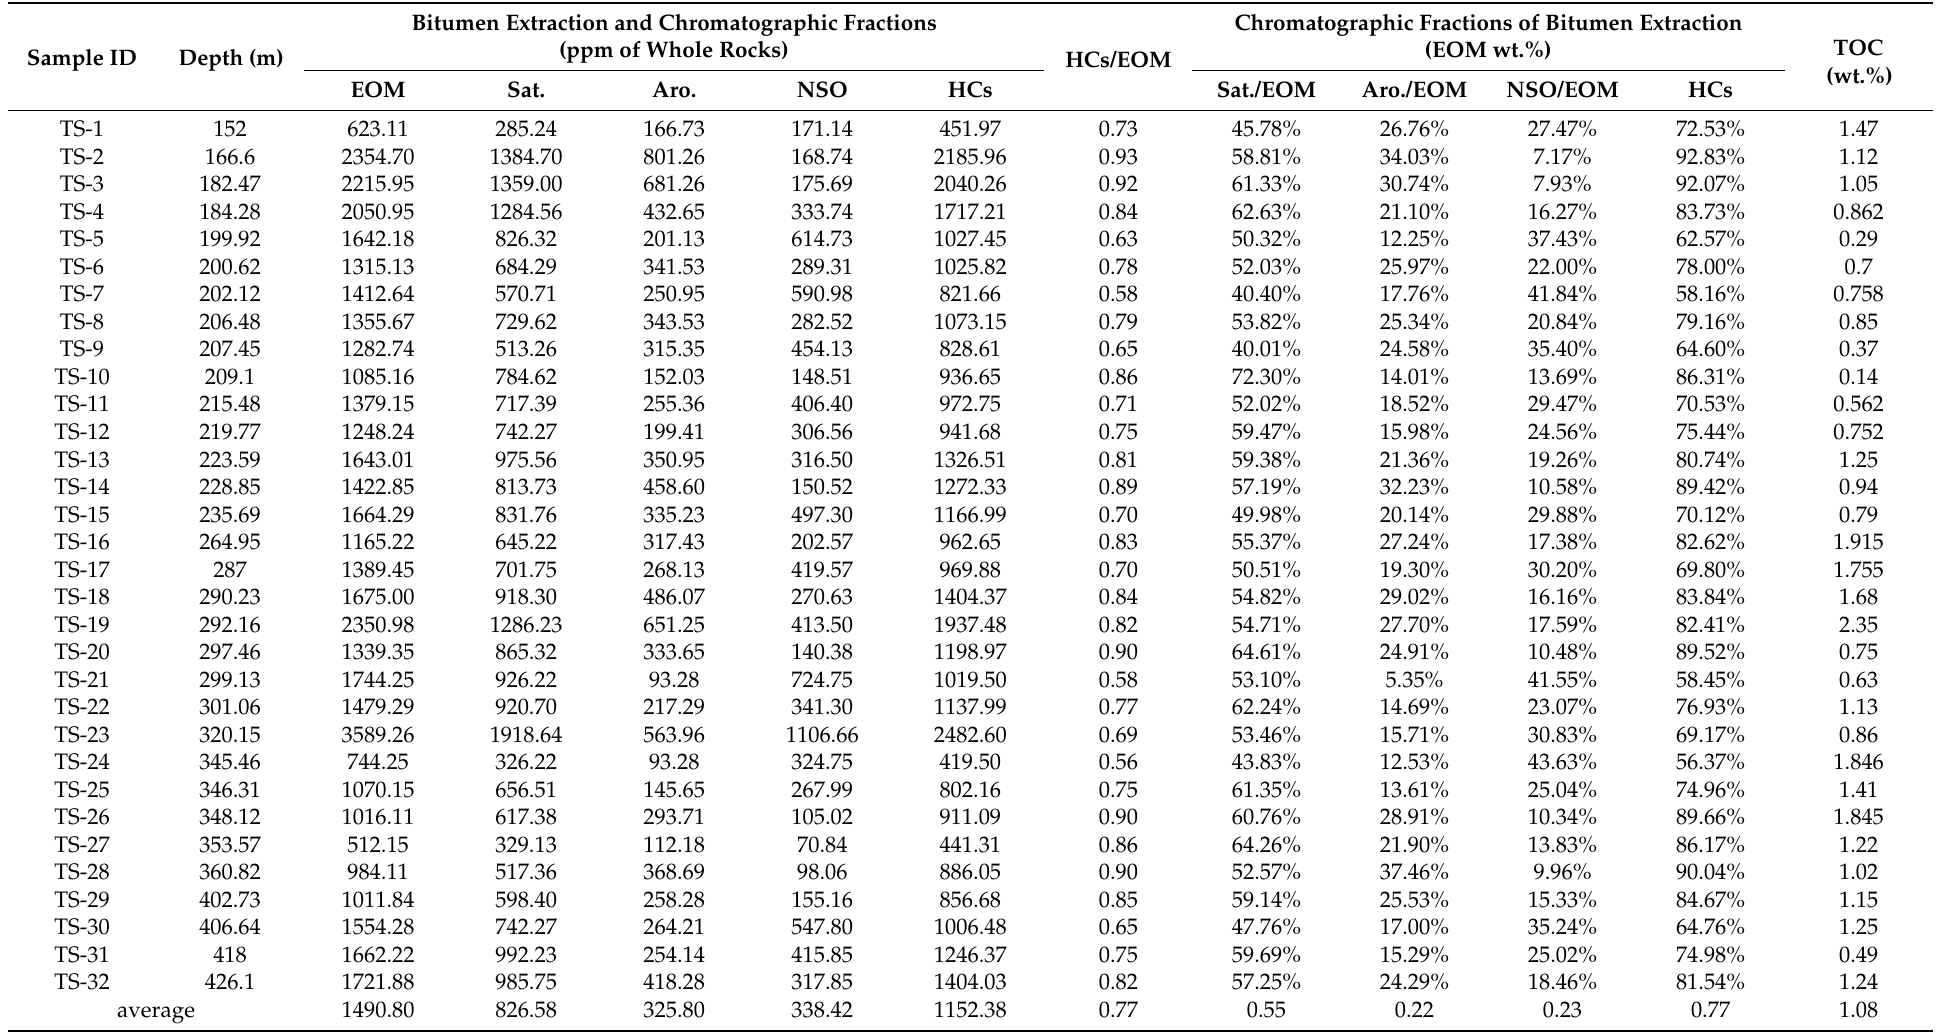
Table 3. Results of extractable organic matter (EOM) yields and the relative proportions of the saturated hydrocarbon fractions, aromatic hydrocarbon fractions and NSO compounds (EOM: extractable organic matter; Sat.: saturated hydrocabons; Aro.: aromatic hydrocarbons; NSO: heterocompounds; HCs.: saturated hydrocarbons + aromatic